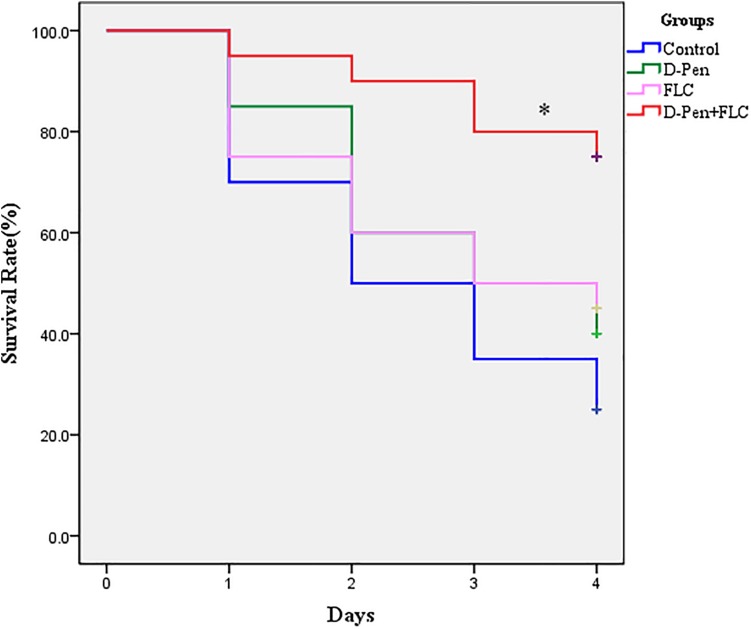
Survival curve of Galleria mellonella infected with Candida albicans. The concentration of yeast cells was 5 × 108 CFU/larva. Treatments consisted of PBS, fluconazole (FLC) (160 μg/ml), D-penicillamine (PCA) (40 μg/ml), and a combination of FLC (160 μg/ml) with PCA (40 μg/ml). The data came from the means of three independent experiments. ∗P < 0.05.